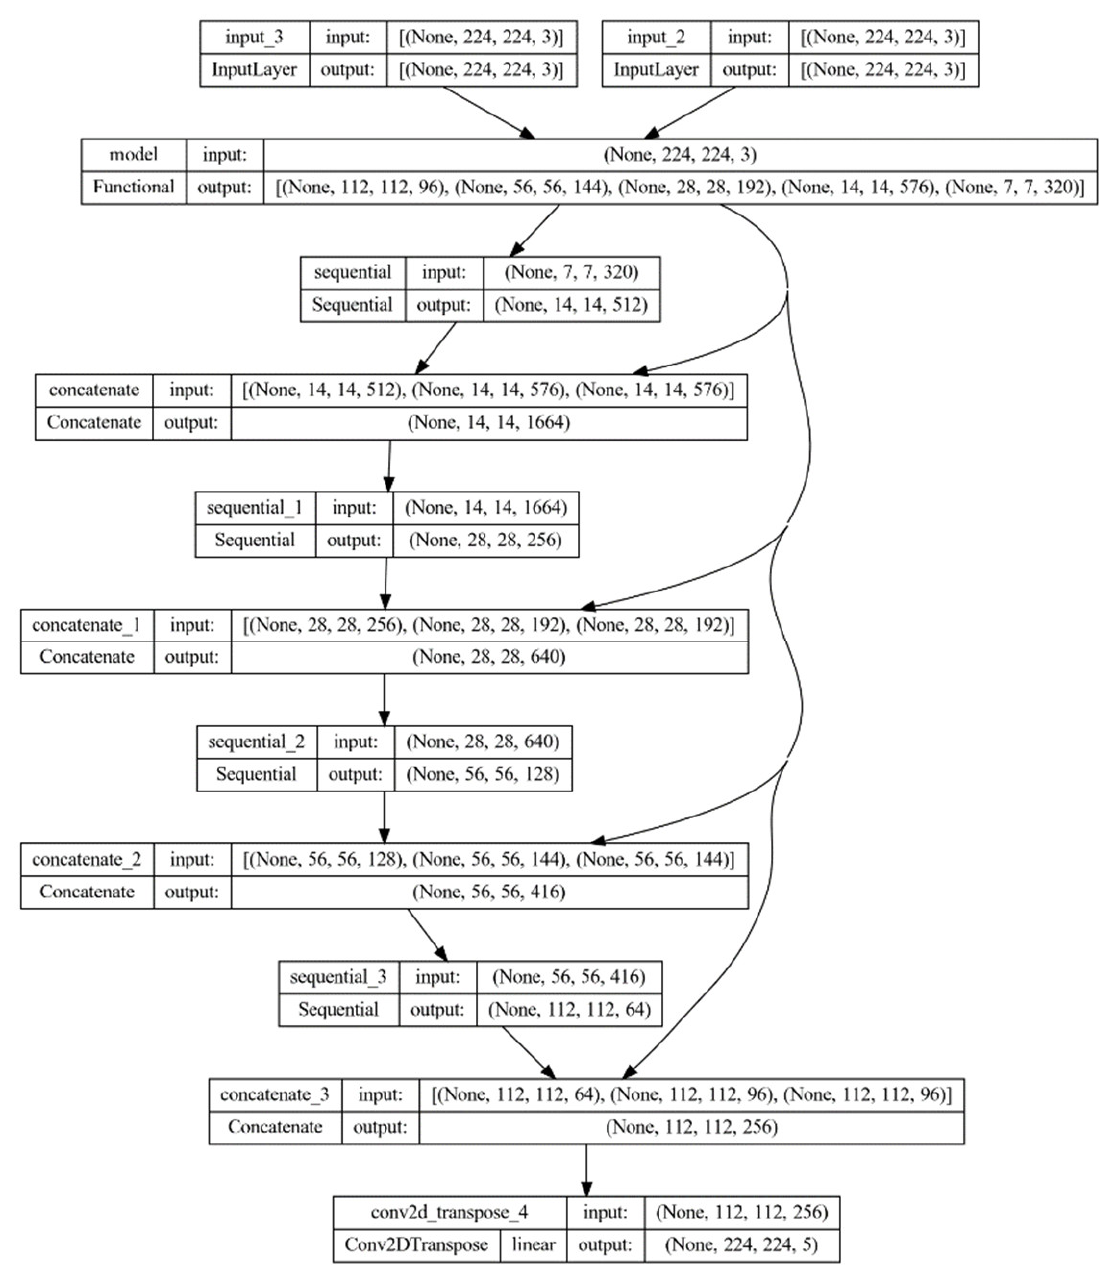
Figure A2. Segmentation model architecture with two data sources as input.